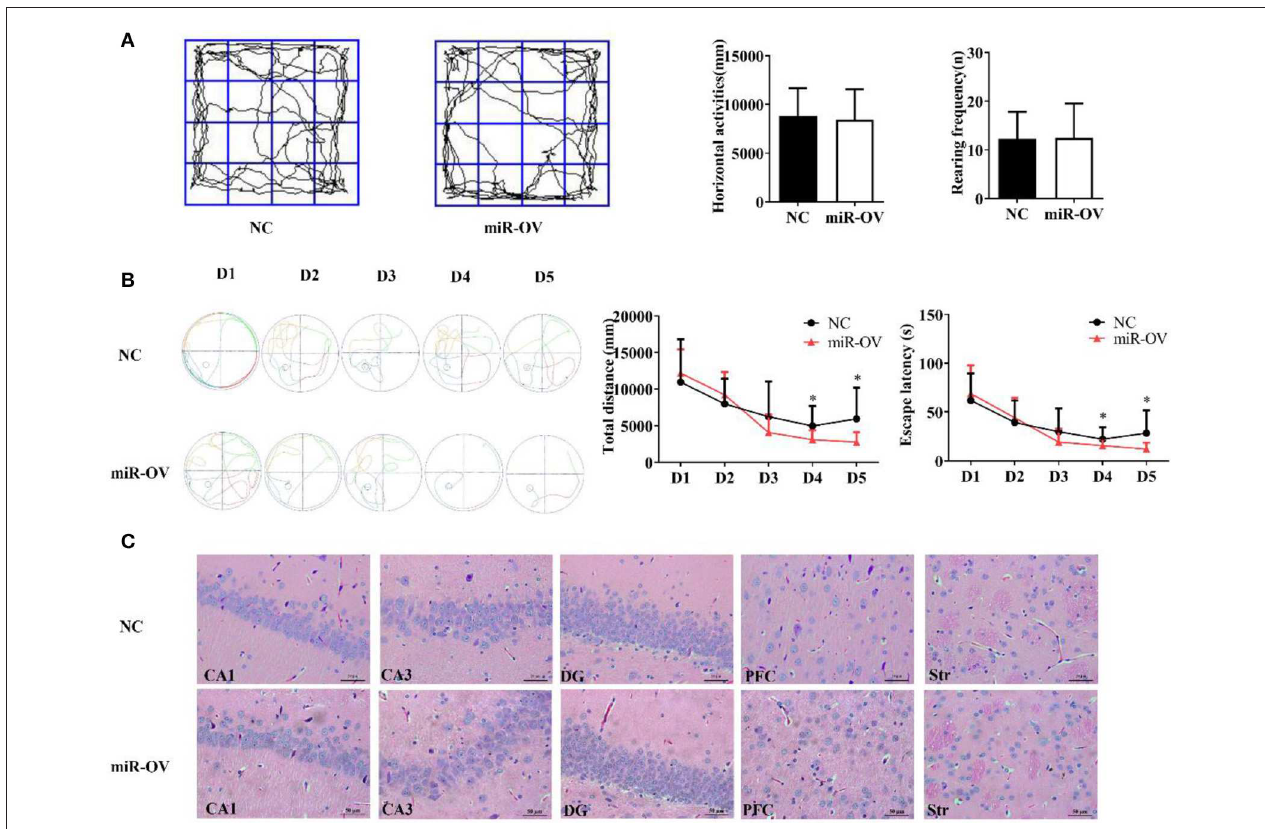
FIGURE 2 | Up-regulation of miR-384-5p improves cognitive behavior without causing histological changes in brain tissue. (A) Path, rearing frequency, and horizontal displacement in the open field test. (B) Path of escape to the platform, total swimming distance, and escape latency in the Morris water maze test. * P < 0.05 (C) H&E staining of Hip CA1, CA3, and DG, PFC, and Str of miR-OV and NC groups. Magnification 400 × .